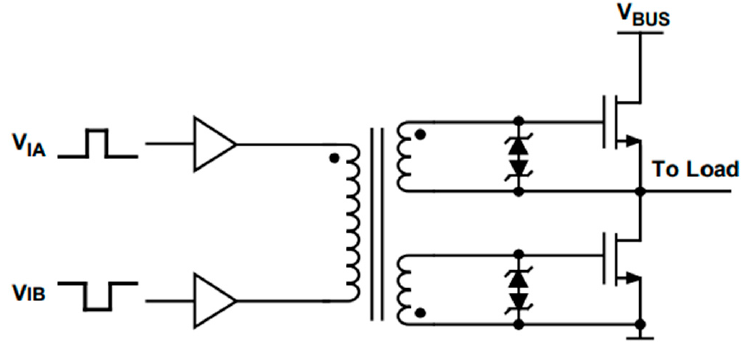
Figure 7. Non isolated DC-DC architecture—Half bridge [43].